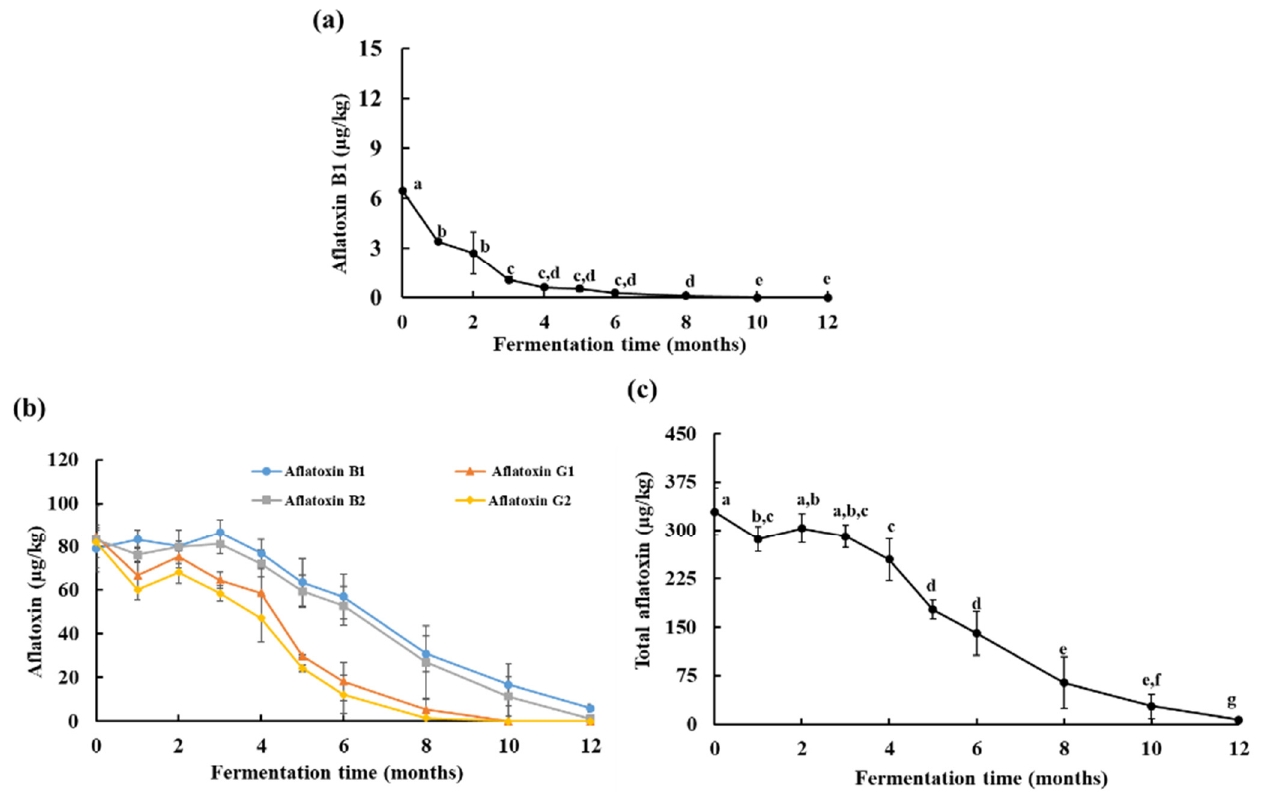
Figure 2. Analysis of aflatoxin in Aspergillus flavus -inoculated and aflatoxin-spiked (100 µg/kg each of aflatoxins B1, G1, B2, and G2) doenjang samples during 12 months of fermentation. ( a ) Quantification of aflatoxin B1 in Aspergillus flavus inoculated doenjang during 12 months of fermentation. ( b ) Time-dependent quantification of aflatoxins B1, G1, B2, and G2 in aflatoxin-spiked doenjang samples. ( c ) Time-dependent quantification of total aflatoxin in aflatoxin-spiked doenjang samples. Each value represents the mean ± standard deviation of three independent experiments. Different letters (a–g) represent a significant difference at p < 0.05.